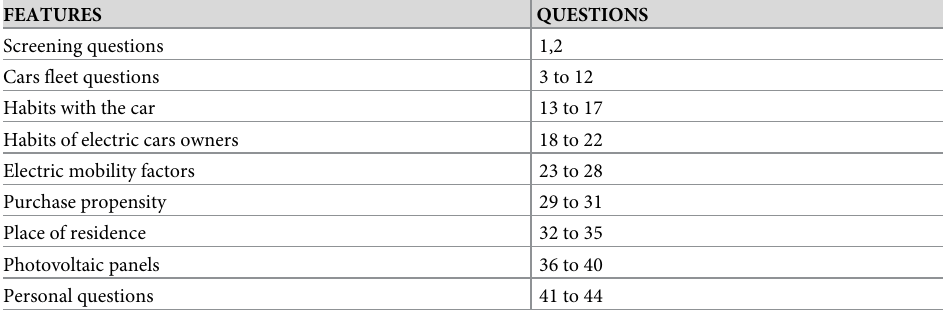
Table describing features types, divided for category which have been collected through the distribution of our survey. In column 1 we describe the features and in column 2 the relative questions in which the features were investigated. A detailed description of all of the questions is reported in S1